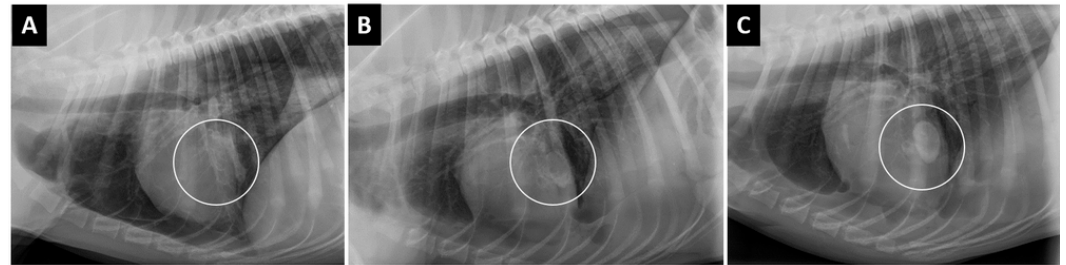
Figure 9. ( A , B , C ) Right lateral projections of a traumatized dog showing changes over time of lung lacerations. ( A ) On admission, an alveolar pattern was noted in the middle lobe area (circle) surrounded by a diffuse interstitial pattern. ( B ) Two days later, in the same area (circle) a large ovoid lesion with hydroaeric level was noted (pneumohematocele). ( C ) Four days after admission, in the same area (circle) the lesion was clearly visible (hematocele); another small lesion, with air–fluid levels, was noted.